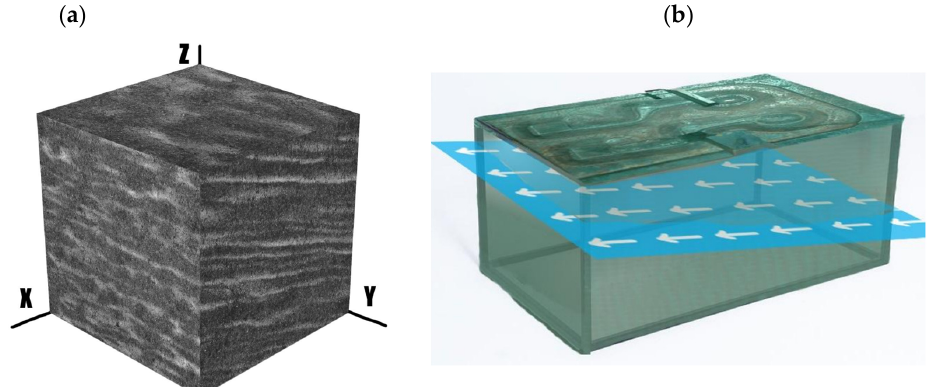
Figure 10. Banding in relation to the forging die geometry: ( a ) 3D image of banding structure, ( b ) alignment of bands in relation to forging die geometry.